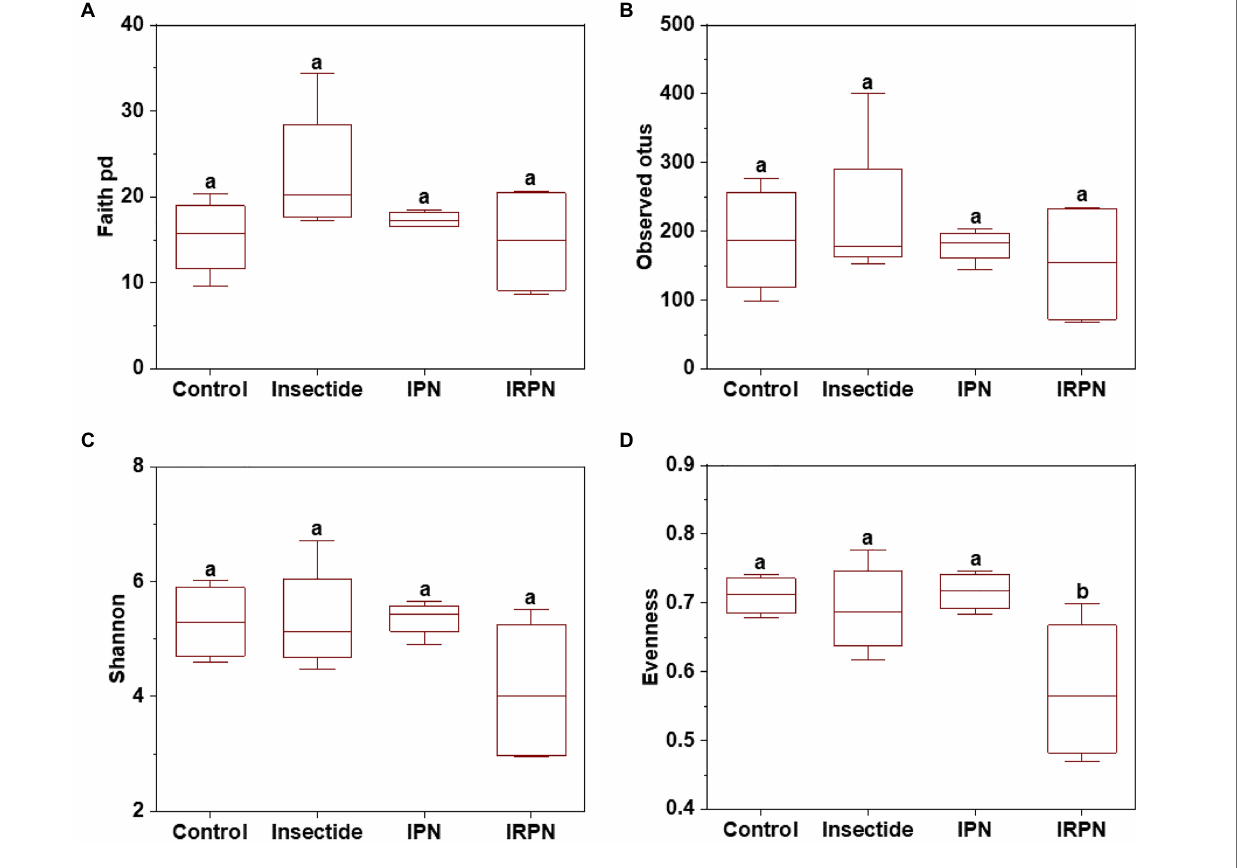
FIGURE 4 | α -diversity of microbial communities of Chinese bayberry trees grown under different treatments. Faith_pd (A) , observed_otus (B) , Shannon (C) and evenness (D) of the bacterial communities in fruits collected from trees grown under natural conditions (controls) or treated separately with insecticides, IPNs or